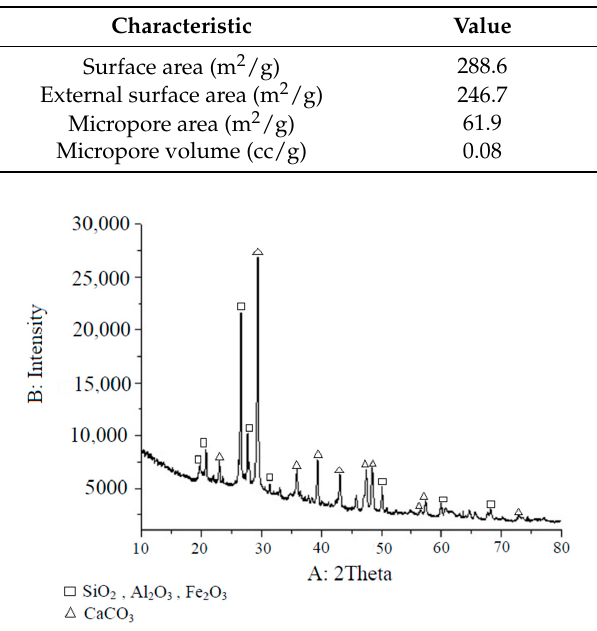
Table 2. Powdered BAZLSC characteristics.